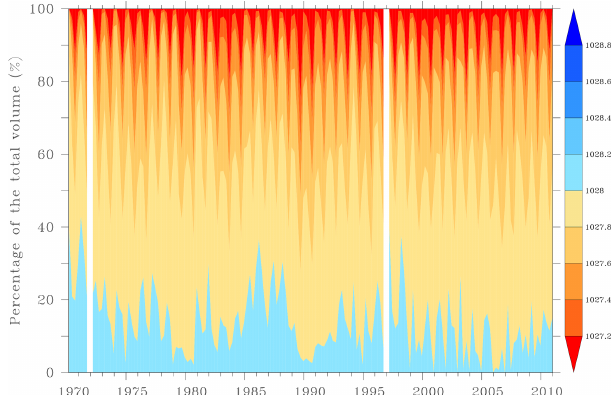
Figure 10. Volumetric temperature classes ranging from − 1 to + 7 ◦ C in the most reliable area per season between 1965 and 2015.